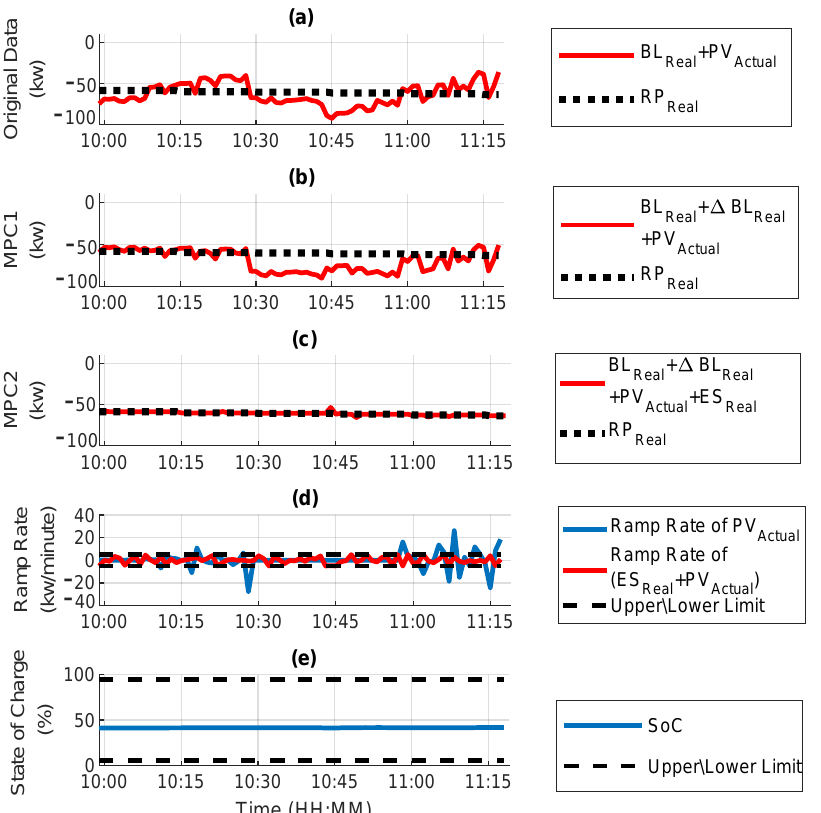
Figure 17. Scenario 3—algorithm performance for real power ( a ) original data, ( b ) MPC1 simulation result, ( c ) MPC2 simulation results, ( d ) ramp rate constraint, and ( e ) energy storage SoC